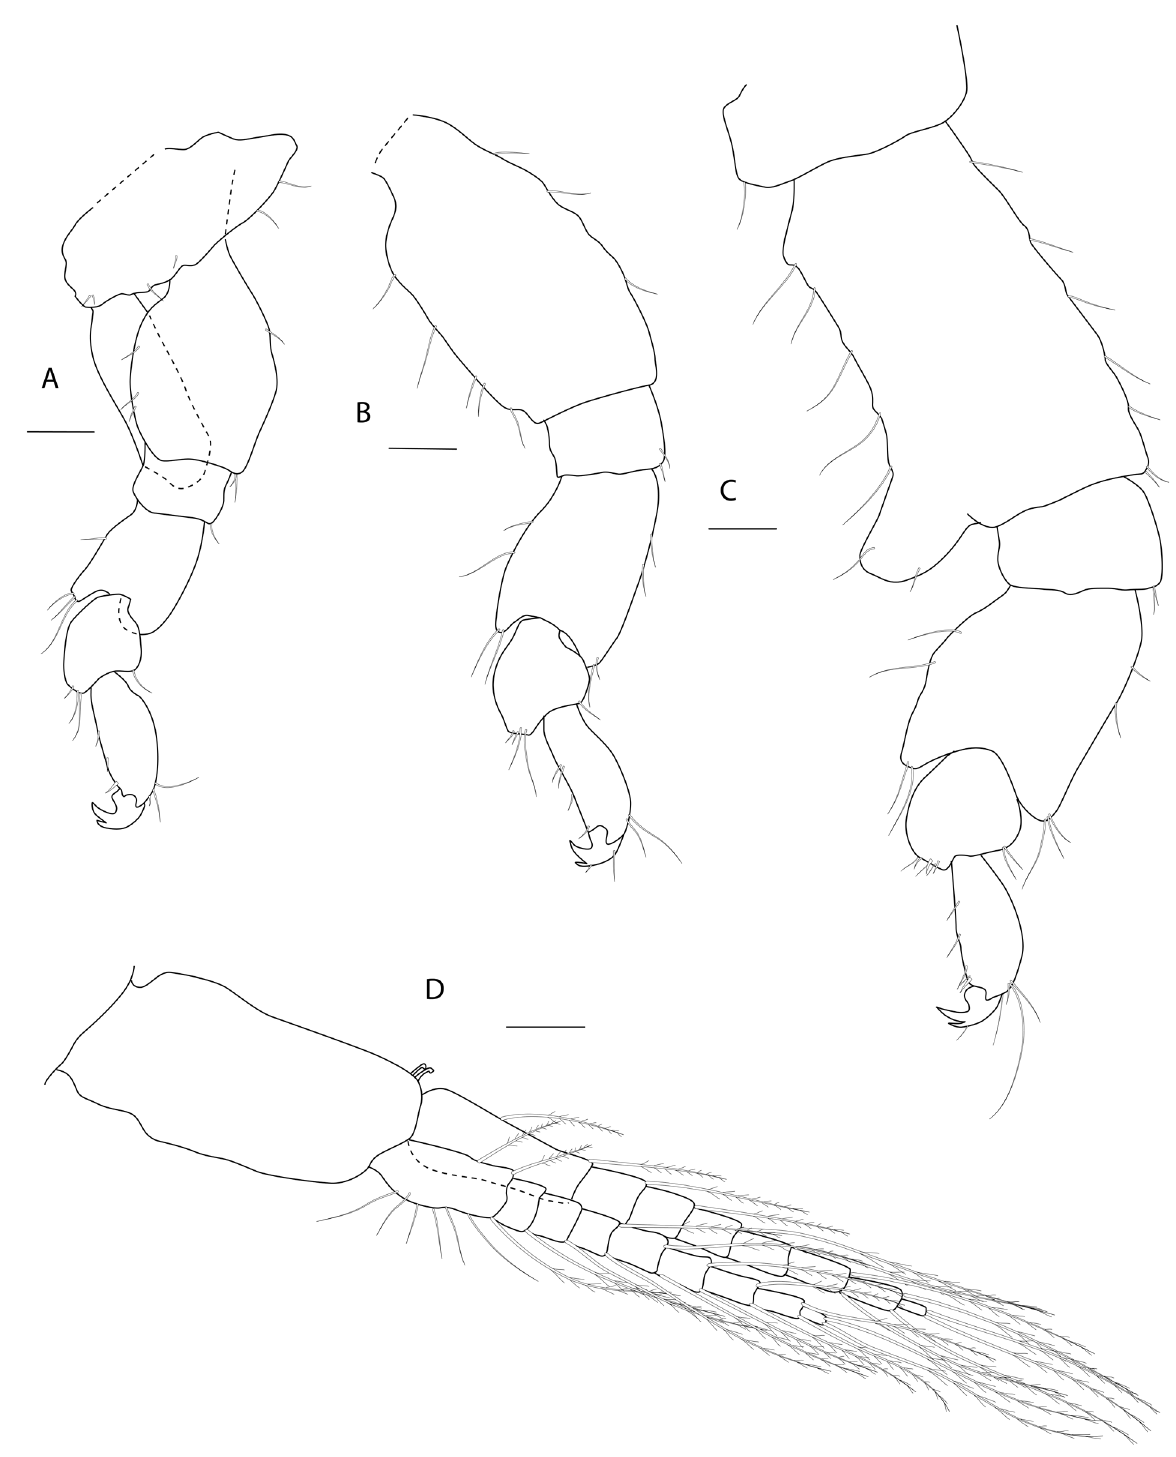
Fig. 6. Bryoconversor tutus gen. et sp. nov., holotype, ♀, NIWA 88918, 1.72 mm long. A . Pereopod 5. B . Pereopod 6. C . Pereopod 7. D . Pleopod 1. Scale bars = 100 μ